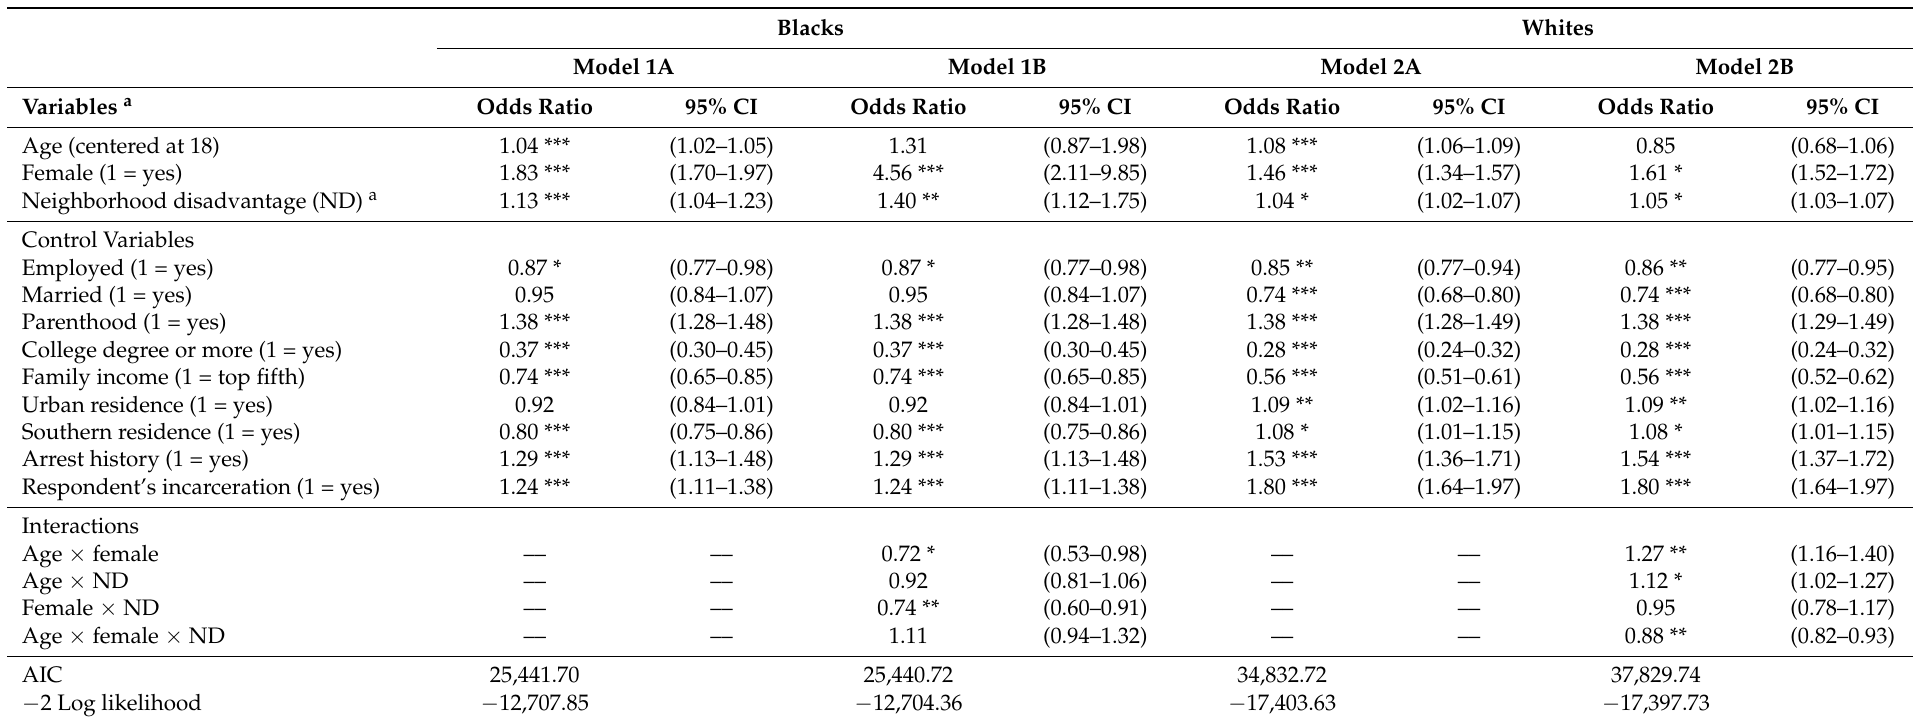
Table 2. Generalized estimating equations for poor health by race. National Longitudinal Survey of Youth 1997 (NLSY97), 1997–2013. Blacks